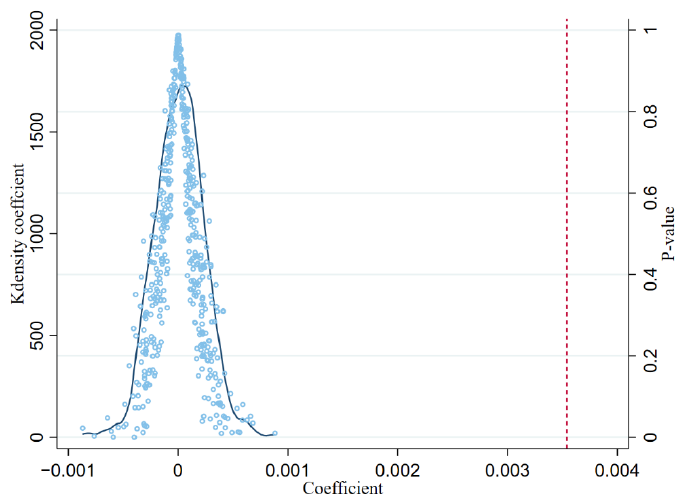
Figure 2. Placebo Figure 2. Placebo test.